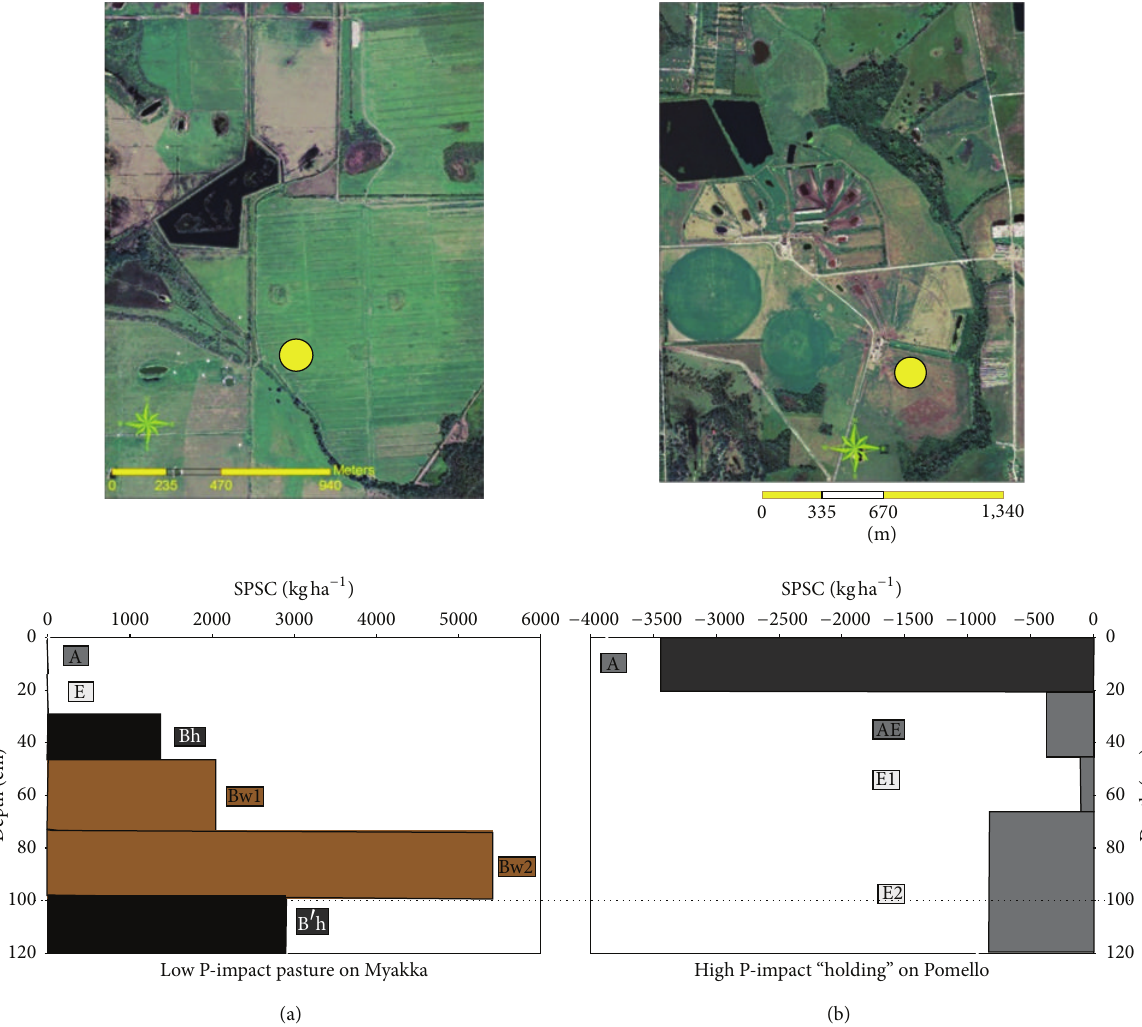
Figure 4: Water table management in two soils with different P-impact levels. On the left is a low P-impact pasture on a Myakka soil series with the Bh at approximately 30 cm depth. On the right is a heavily P-impacted cattle holding area on a Pomello soil without any Bh horizon to a depth of 120 cm. A hypothetical water table represented by a dotted line is at a 100cm depth. Data was compiled by M. Chrysostome and the GIS maps generated by S.